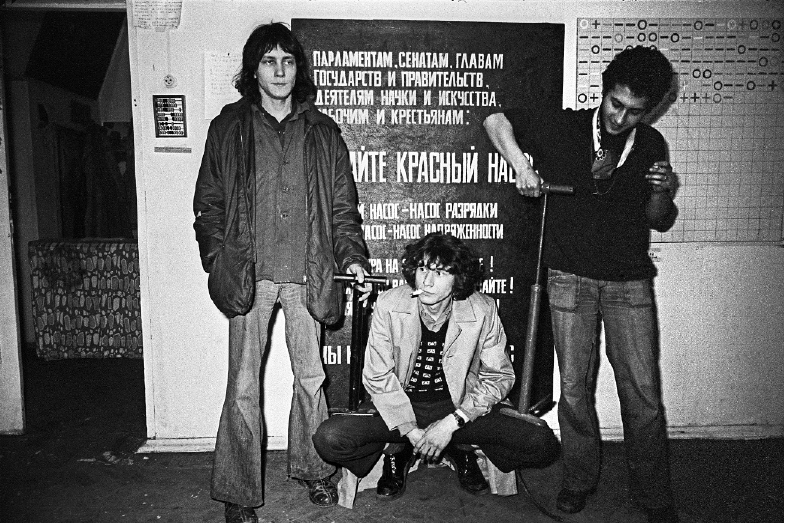
Figure 2. The Nest. Pump the Red Pump! 1975. Oil on fiberboard, two pumps, 175 cm × 120 cm. Installation view. Image courtesy of Victor Skersis.